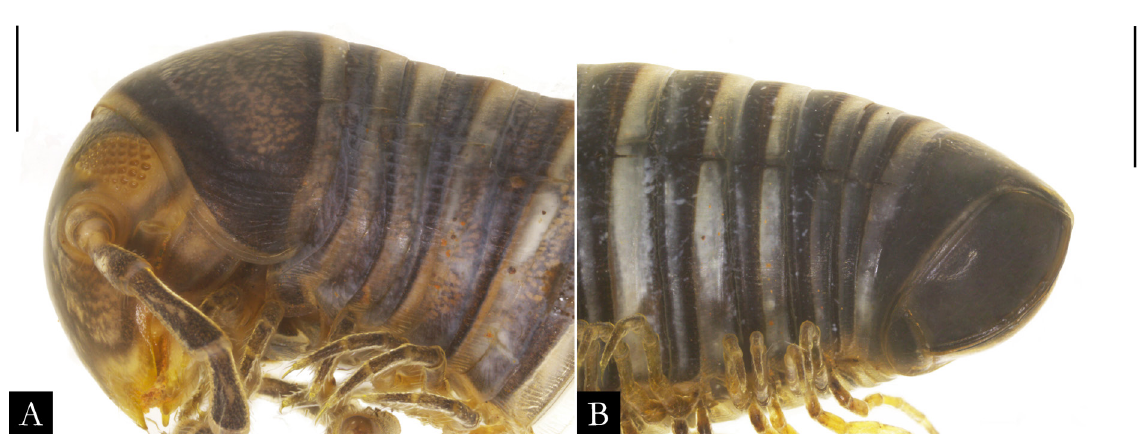
Fig. 117. Pseudonannolene rolamossa Iniesta & Ferreira, 2013, ♂ (ISLA 15054), in lateral view. A . Anterior region. B . Posterior region. Scale bars = 1